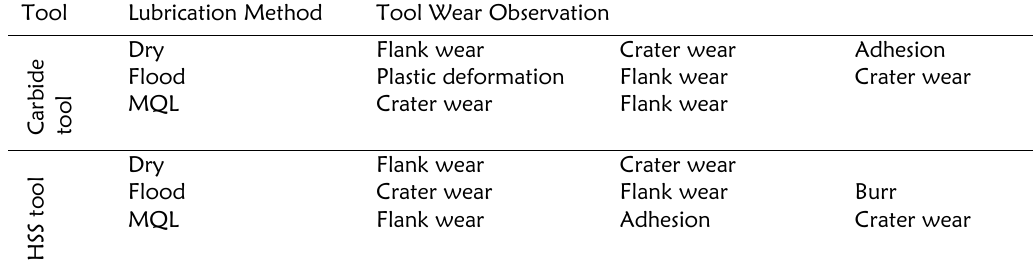
Table 2: Types of wear found on the